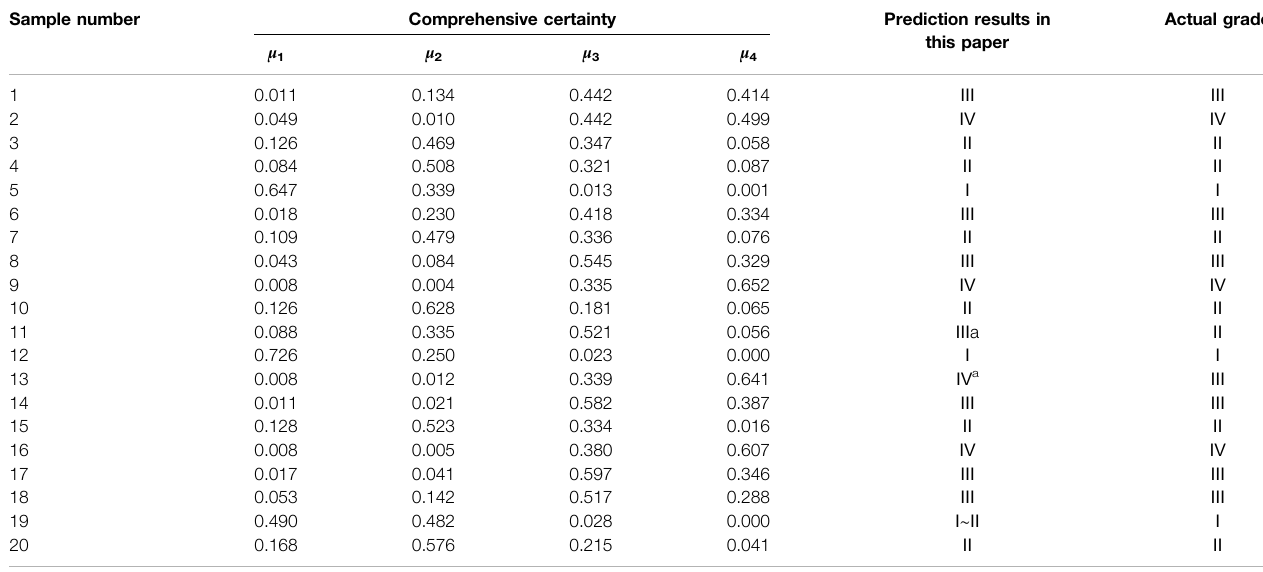
TABLE 6 | Rock burst propensity prediction results.